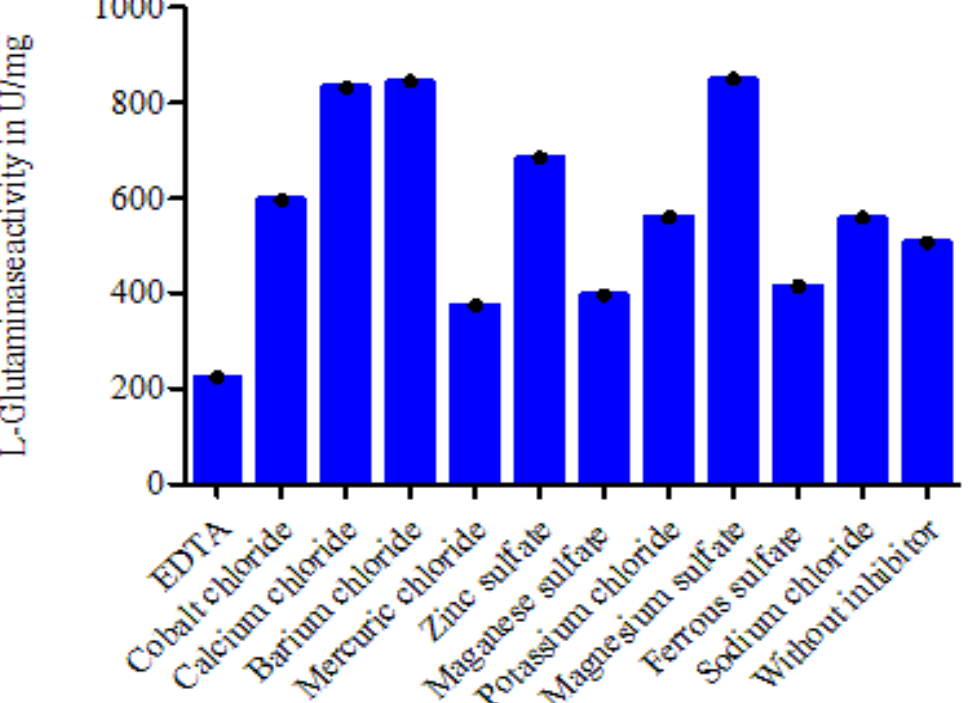
Figure 14. Effect of metal ions on L-glutaminase activity produced by A. xylosoxidans RSHG1 at 40 ◦ C, pH